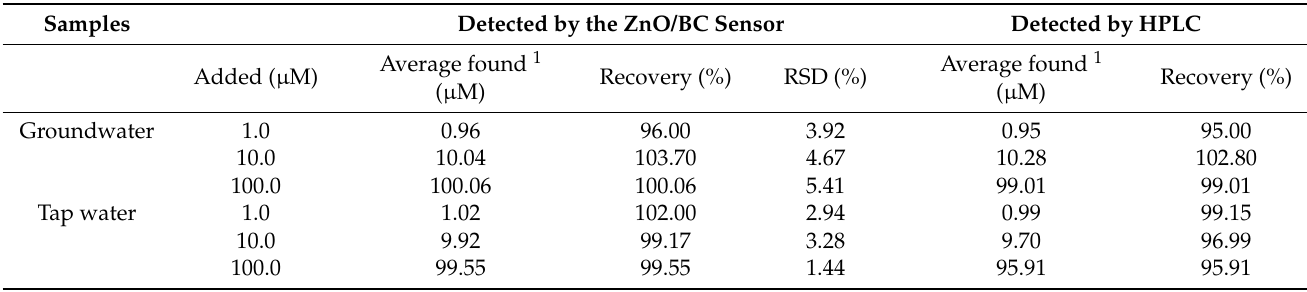
Table 2. Determination of BPA in real water with the ZnO/BC sensor and